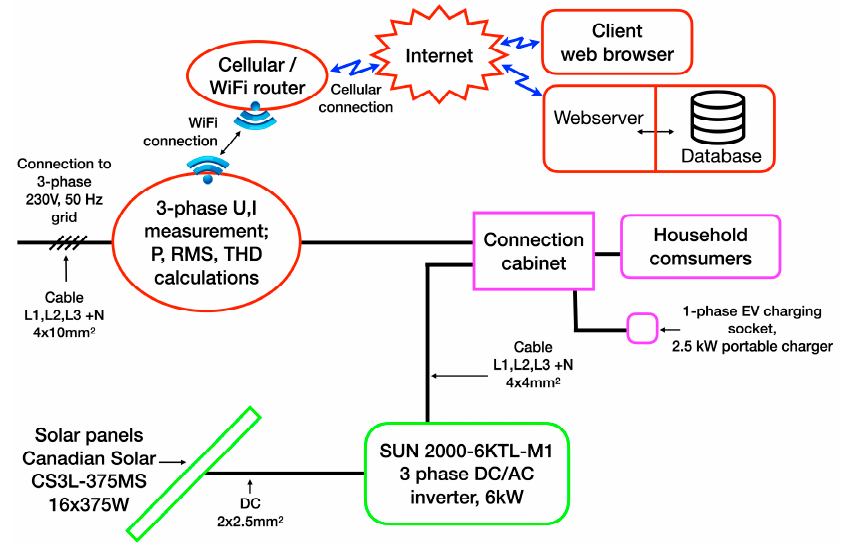
Figure 1. Household measurement system installation diagram.